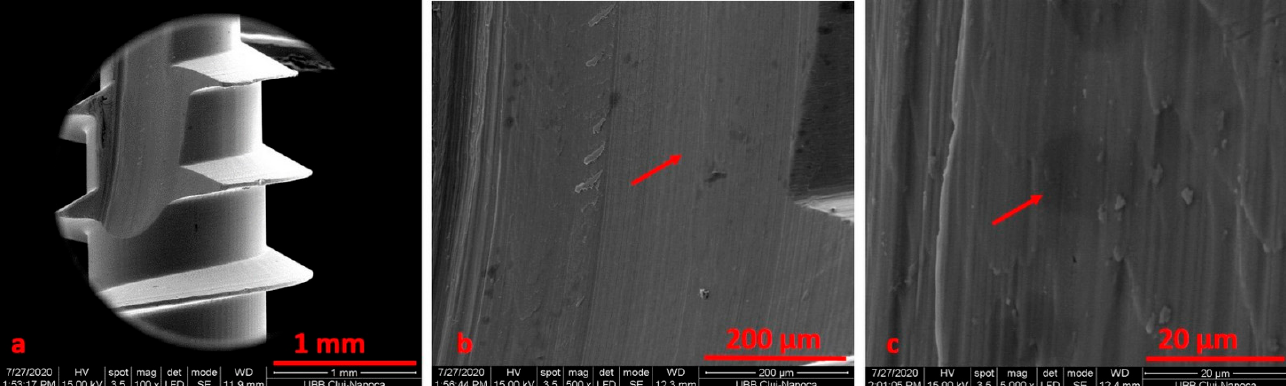
Figure 5. SEM image for the TADs (patient 1) after electrochemical treatment using Ringer’s Solution at ×100 ( a ), ×500 ( b ), ×5000 ( c ) magnification.